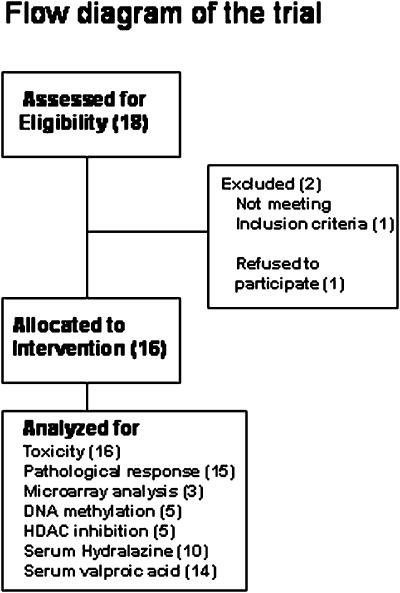
Flow diagram of the trial.